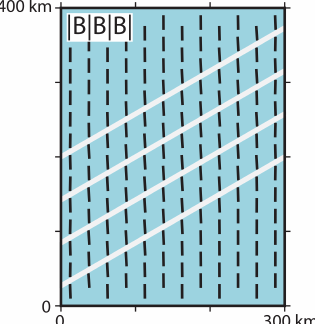
Figure 9. Influence of low-friction faults on the far-field stress ori- entation. Black bars represent the orientation of S Hmax at a depth of 1000m. All areas have the properties of the reference material (Table 2). White lines indicate cohesionless discontinuities (verti- cal faults). The model using a friction coefficient of µ = 0 . 1 along the three discontinuities is shown. The other models with a larger friction coefficient (up to 1 and larger) have similar results; they are waived out because of the visual